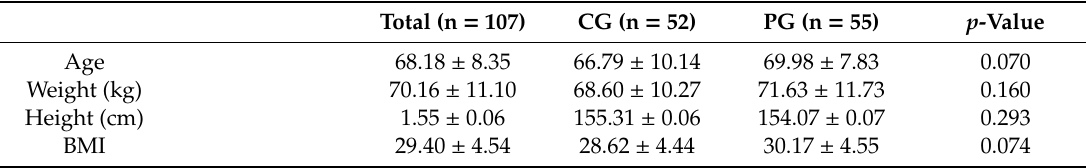
Table 1. Baseline characteristics of the study